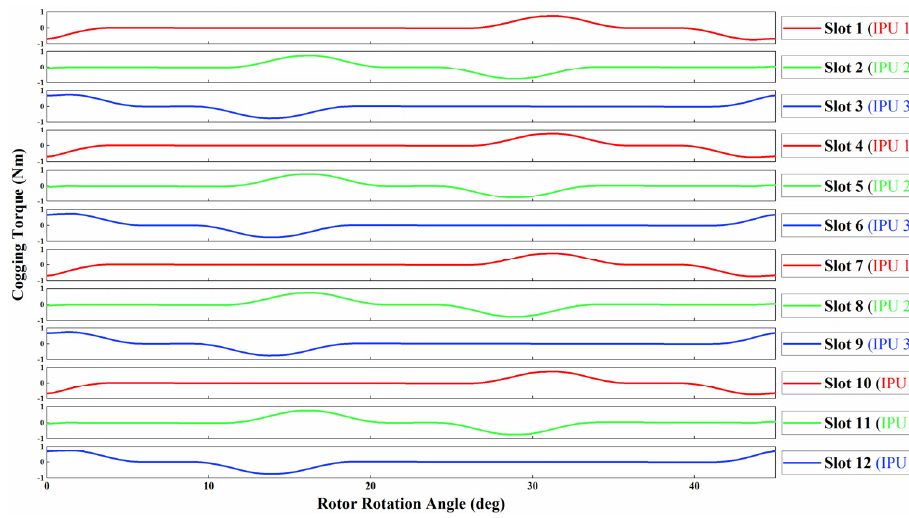
Figure 2. The cogging torque generated by each stator slot opening of an 8-pole, 12-slot machine.